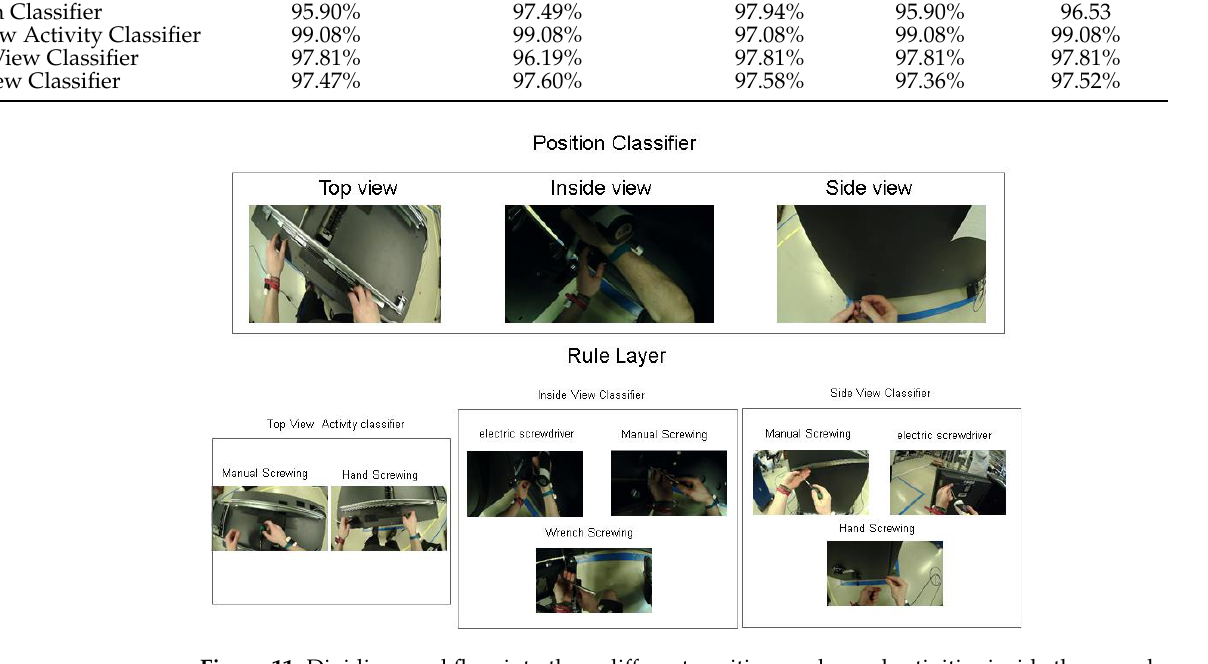
Figure 11. Dividing workflow into three different position angles and activities inside these angles.